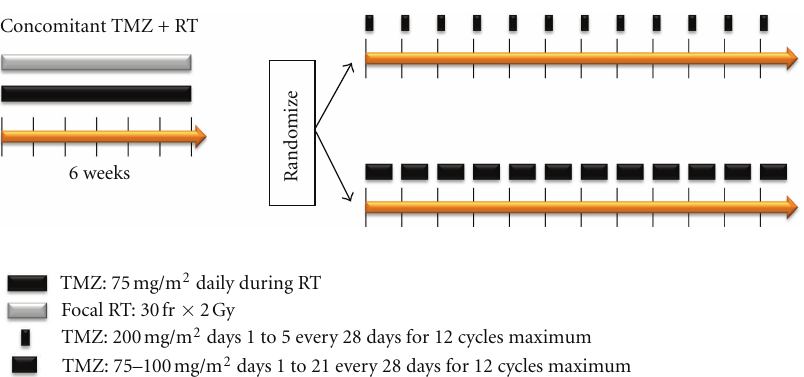
Figure 1: RTOG 0525/EORTC 26052-22053 (dose-dense) study. The study aimed to determine if intensified TMZ (75–100 mg/m 2 × 21 days, q4weeks) improves overall survival or progression-free survival compared to the standard arm (150–200 mg/m 2 × 5 days,